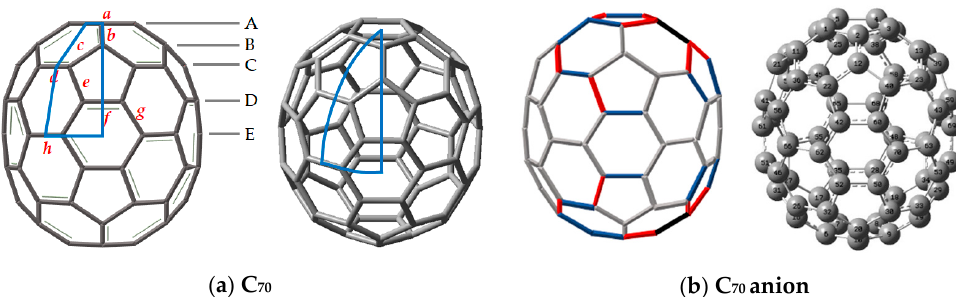
Figure 1. ( a ) The five inequivalent atoms in the D 5h structure of the C 70 neutral fullerene molecule are denoted by lowercase letters. In C 70 , the bond lengths ( a , b , c , d , e , f , g , and h ) are as follows: 1.452, 1.397, 1.449, 1.389, 1.450, 1.434, 1.421, and 1.470 Å, respectively. Here, A – E levels represent five different types of carbon atoms from a curvature viewpoint. The representative patch (blue line region) in ( a ) is the unit cell of C 70 with respect to the D 5h point group symmetry. ( b ) The point group of C 70 anion is C 2v reduced from D 5h symmetry, which is represented with colors on the unit cell.